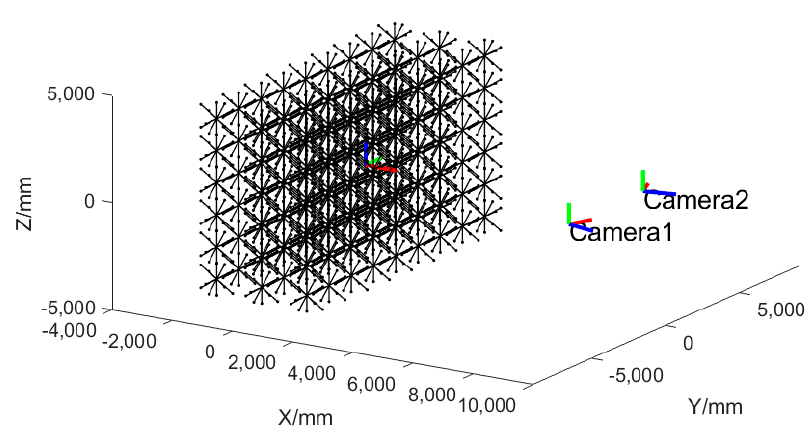
Figure 5. The simulated control length array and the camera pair.